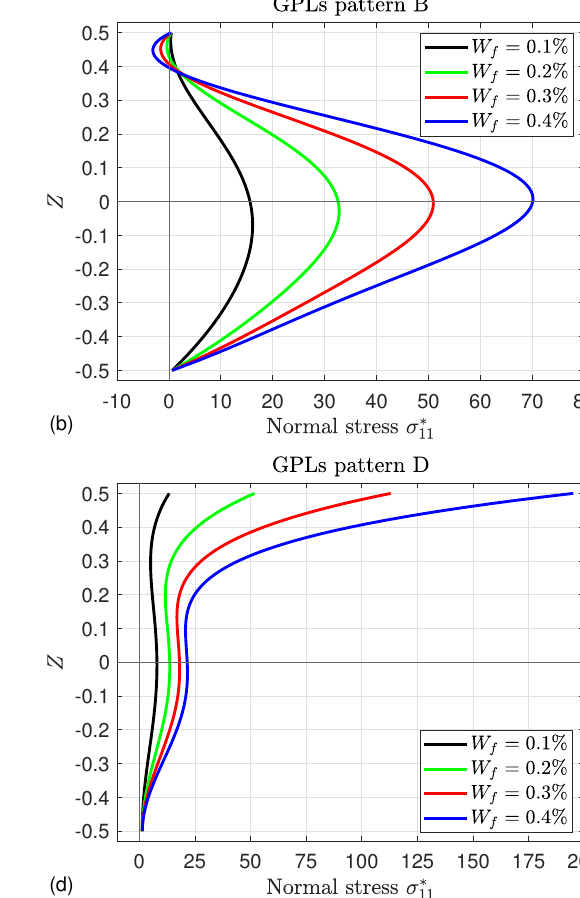
in FG porous nanocompos- 11